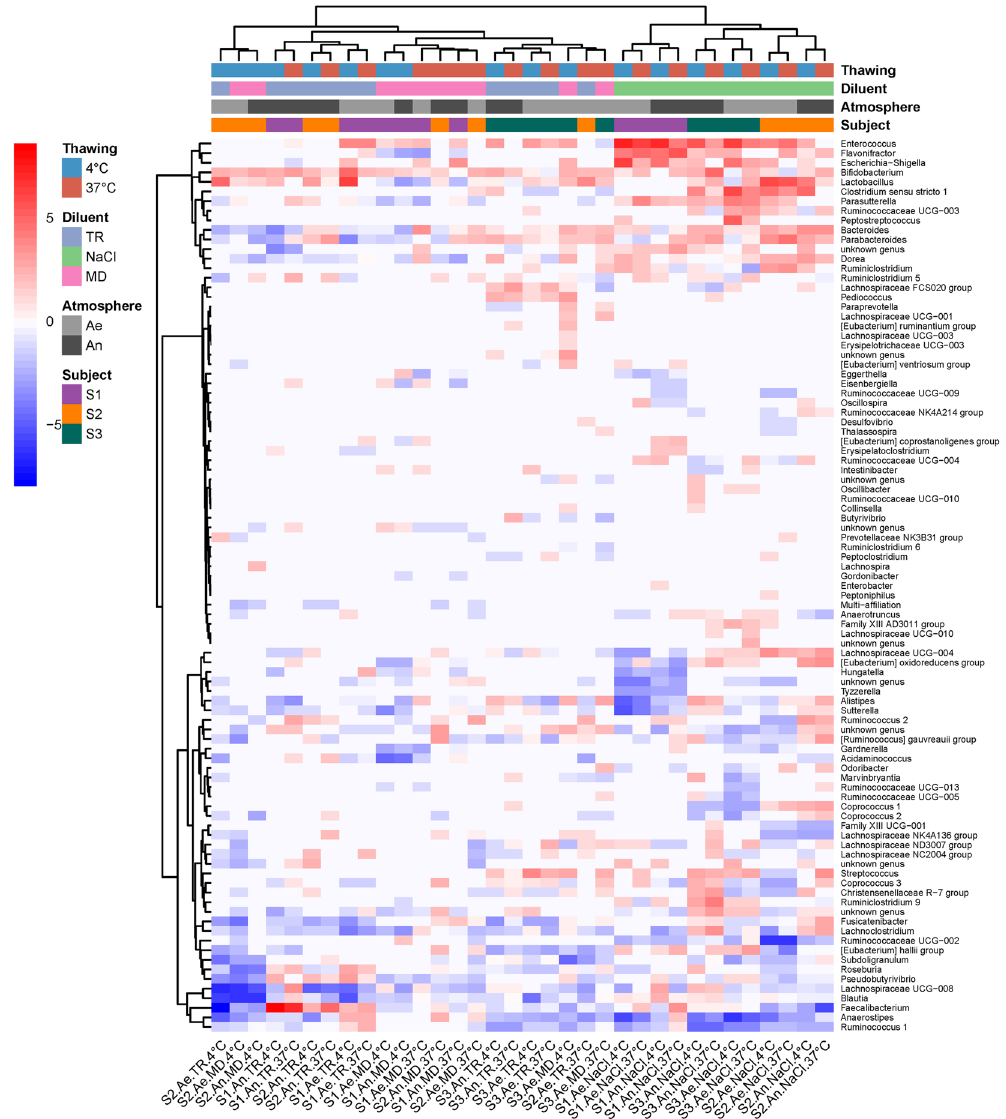
Figure 5. Heatmap of log2(condition/baseline) for genus abundance in cultures of fecal transplants (from three individuals S1, S2 and S3) that have been frozen at -80 °C for two weeks. Conditions are combinations of conditioning atmosphere (An and Ae for anaerobiosis and aerobiosis, respectively), diluent (NaCl, MD or TR), and thawing protocol (5 min at 37 °C in a water bath or overnight at 4 °C). Baseline is genus abundance in the transplants before